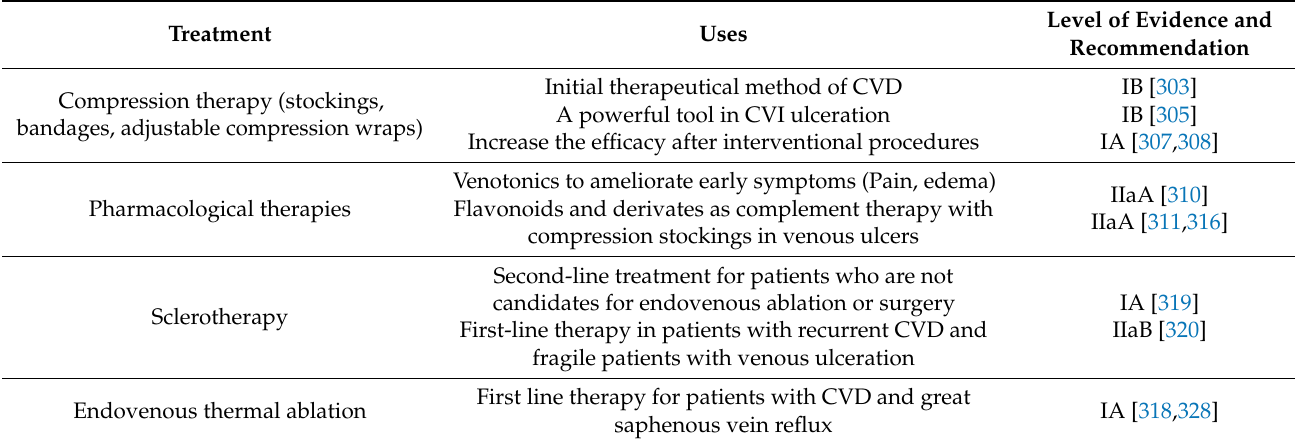
Level of Evidence and Recommendation